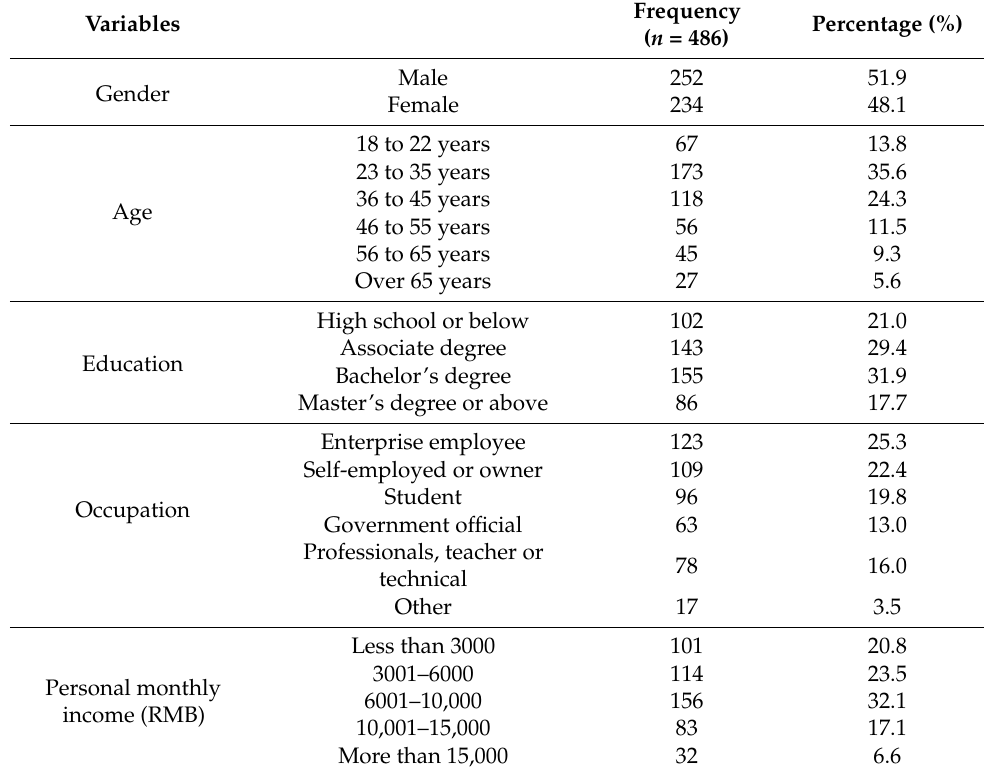
Table 1. Description of the demographic characteristics.